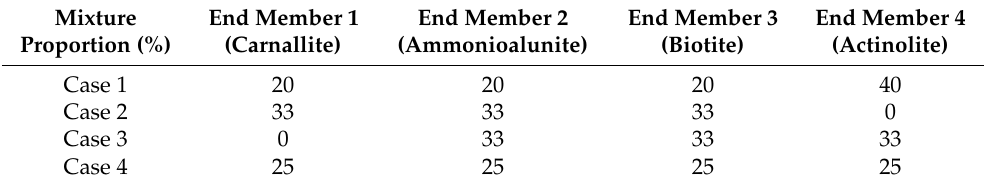
Table 1. Mixture proportions of the simulated